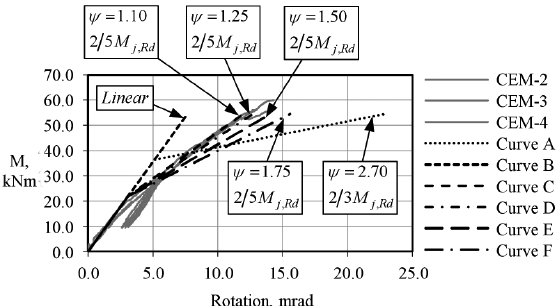
kN/mm)Fig. 8. Different moment-rotation curves: